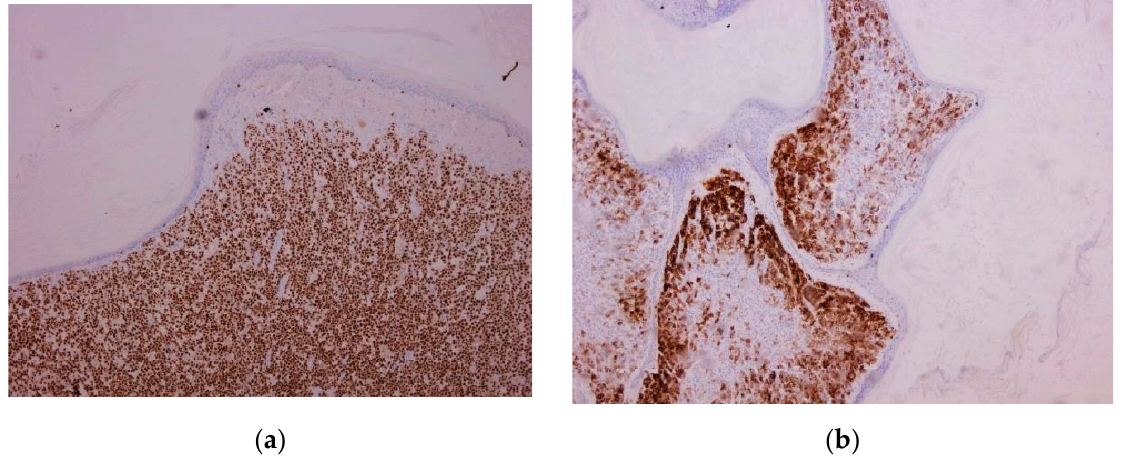
Figure 6. Nevoid melanoma. Tumor architecture at ( a ) 5× magnification showed by SOX10 stain and ( b ) 10 × magnification IHC stain with MelanA. (Collection of Pathology Department SCJ Mures